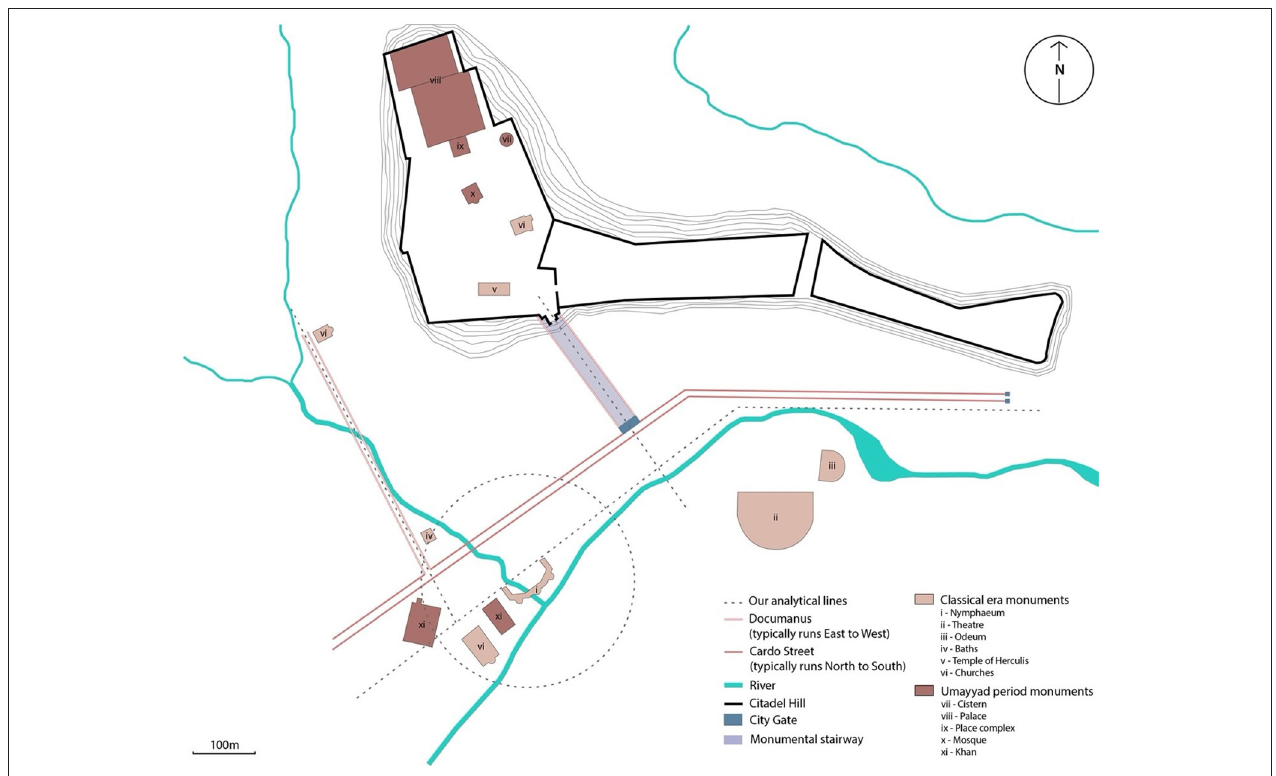
FIGURE 2 | The urban form of Classical era Philadelphia and Umayyad period Amman revered its urban watercourses, primarily the Amman Stream [reproduced from Northedge (1992b) by Sophie Wang under the supervision of Dr. Luna Khirfan–analysis